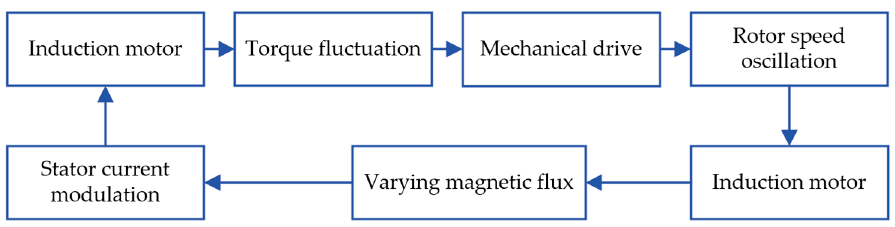
Figure 1. Interaction for modulation current and rotor load and speed.